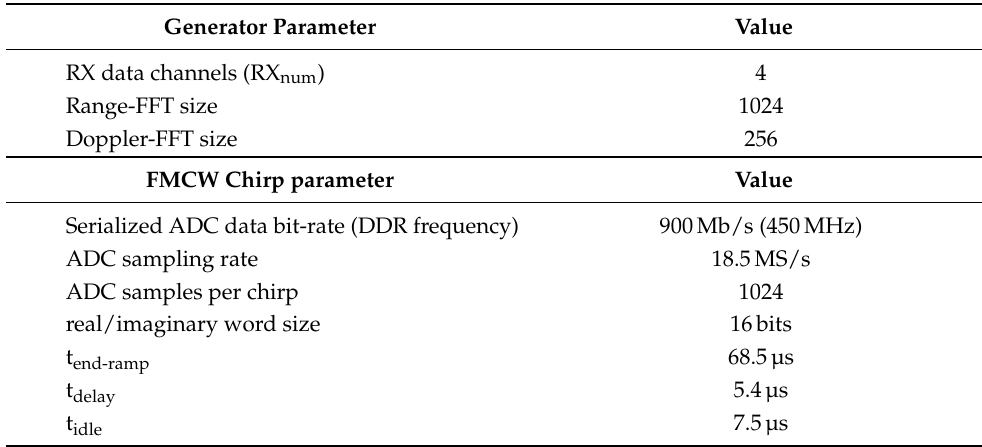
Table 1. Overview of the generator and the FMCW chirp